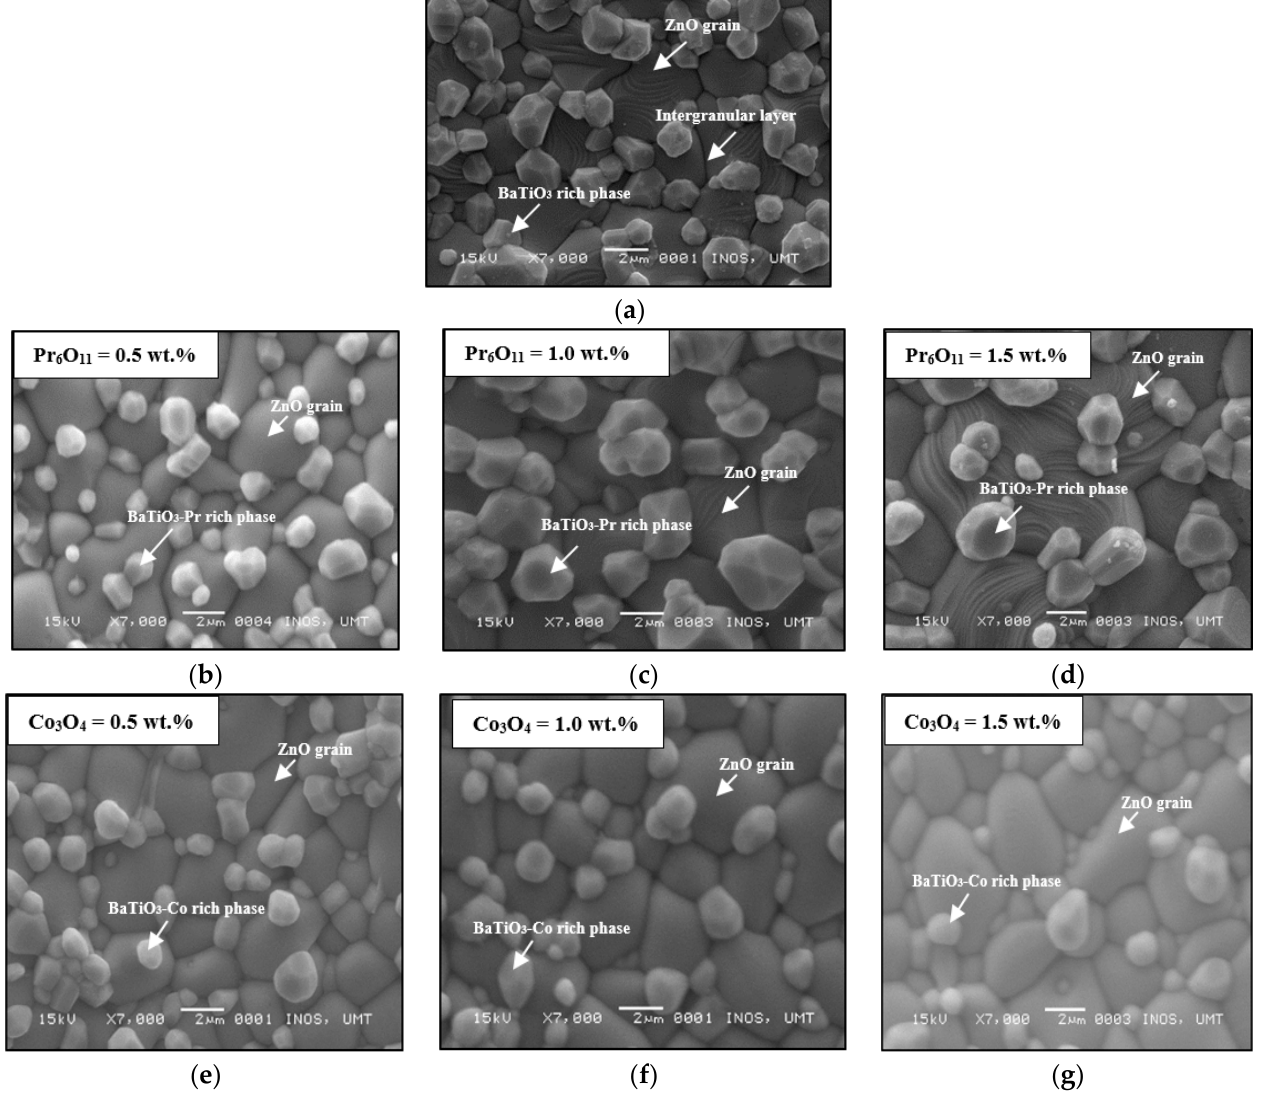
Figure 1. SEM images of ZnO-BaTiO 3 and doped ZnO-BaTiO 3 varistor with different concentration of Pr 6 O 11 and Co 3 O 4 : ( a ) ZnO-BaTiO 3 without dopant, ( b ) 0.5 wt.% (Pr 6 O 11 ), ( c ) 1.0 wt.% (Pr 6 O 11 ), ( d ) 1.5 wt.% (Pr 6 O 11 ), ( e ) 0.5 wt.% (Co 3 O 4 ), ( f ) 1.0 wt.% (Co 3 O 4 ) and ( g ) 1.5 wt.% (Co 3 O 4 ).